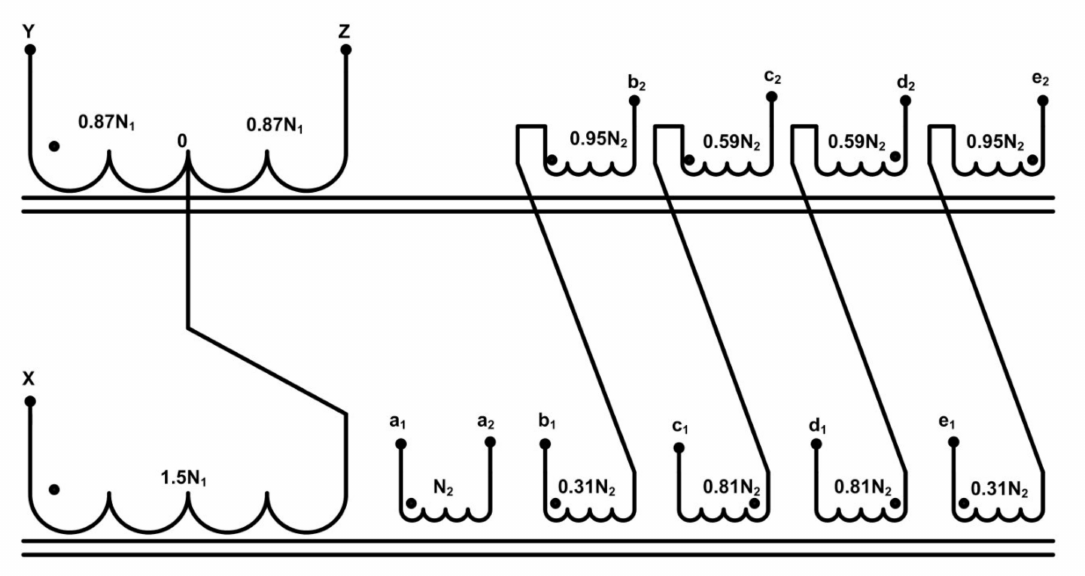
Figure 7. Configuration 3 for a three-phase to the five-phase